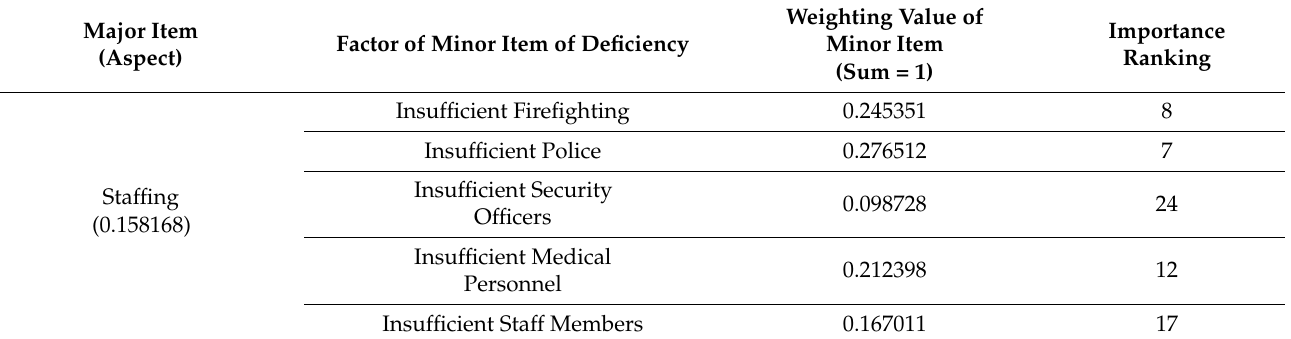
Table 5. Weighting values for staffing.